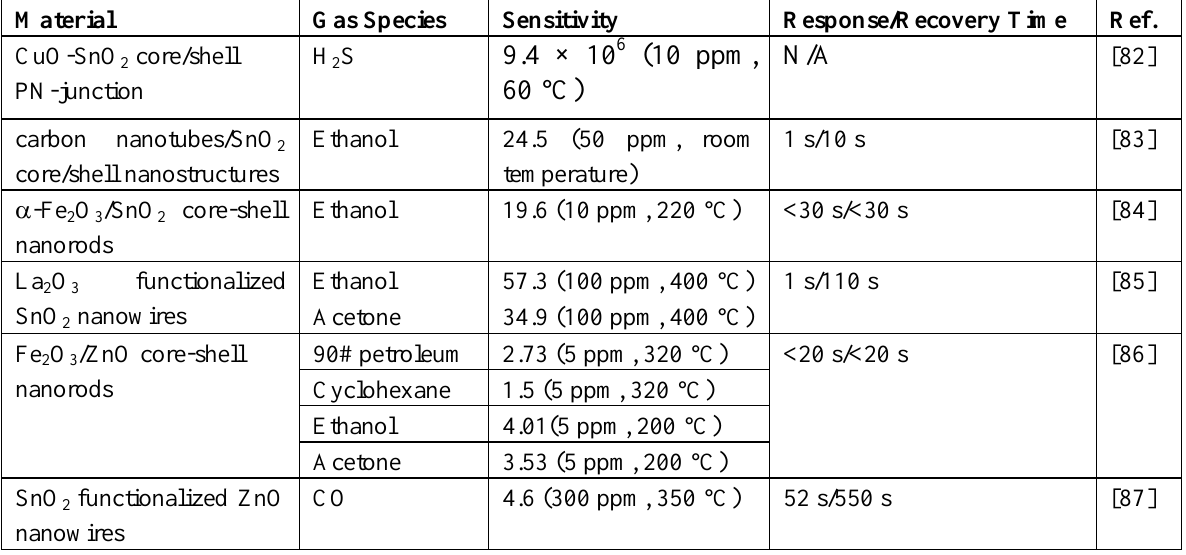
Table 4. Metal oxide heterostructured nanostructures gas